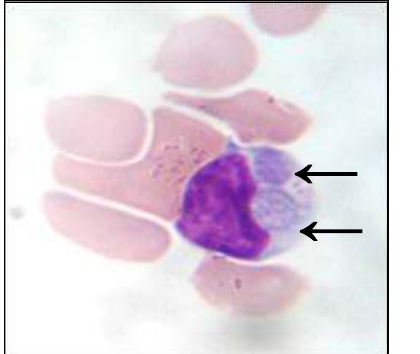
Figure-1. Babesia gibsoni dot with vacuole and band form